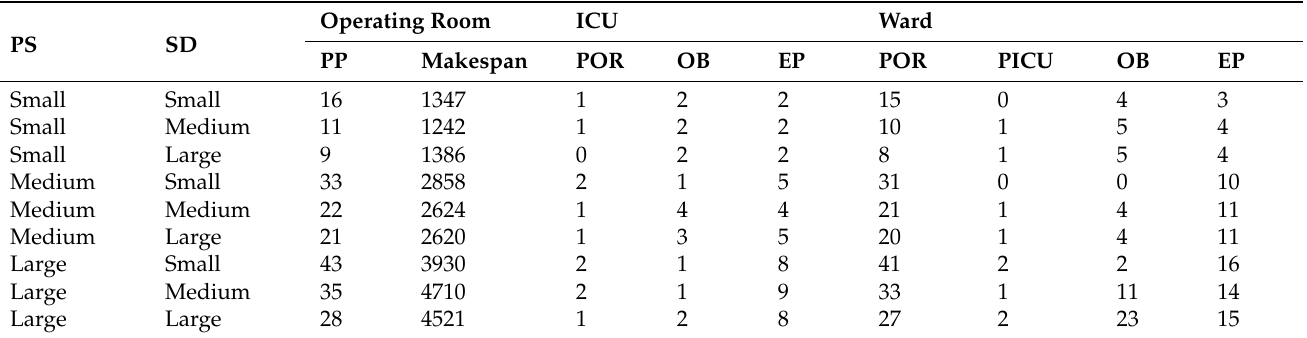
Table 5. Summary results of the lower-level plan when the operating room becomes the